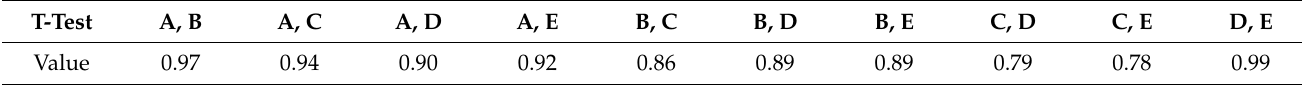
Table A2. T-test results of flexural strength test.